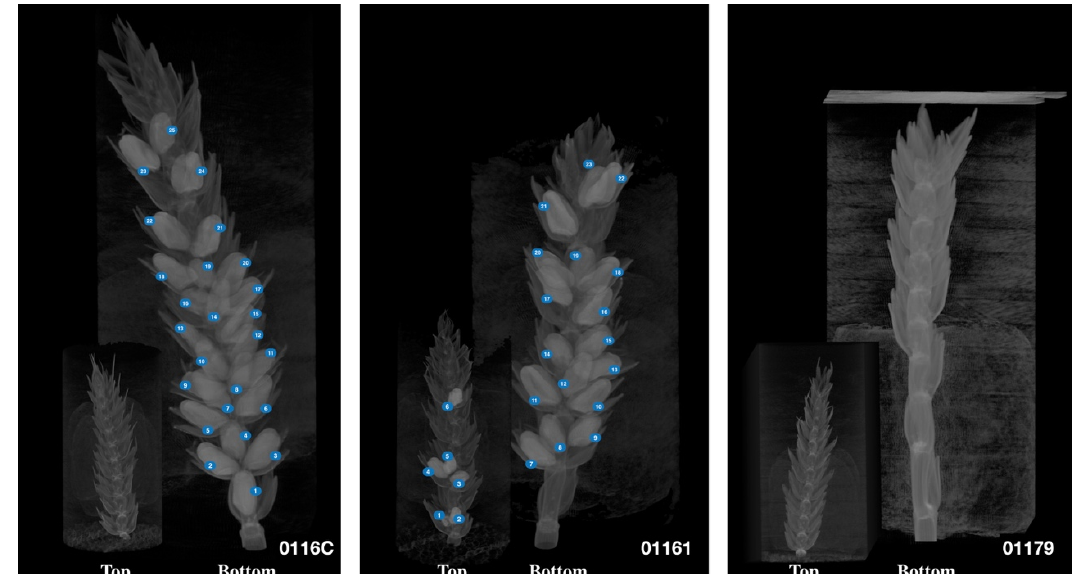
Figure 19. The raw images of the three groups of wheat spikes and the counted grains. Some treatments contain 2 set of images, we all set for one wheat spike in the figure. The treatment No. 0116C contains 25 grains but Hughes counted 24; 01161 contains 23 grains but Hughes counted 22. The treatment No. 01179 has no grain both counted by us and Hughes, but one grain is counted using their method.